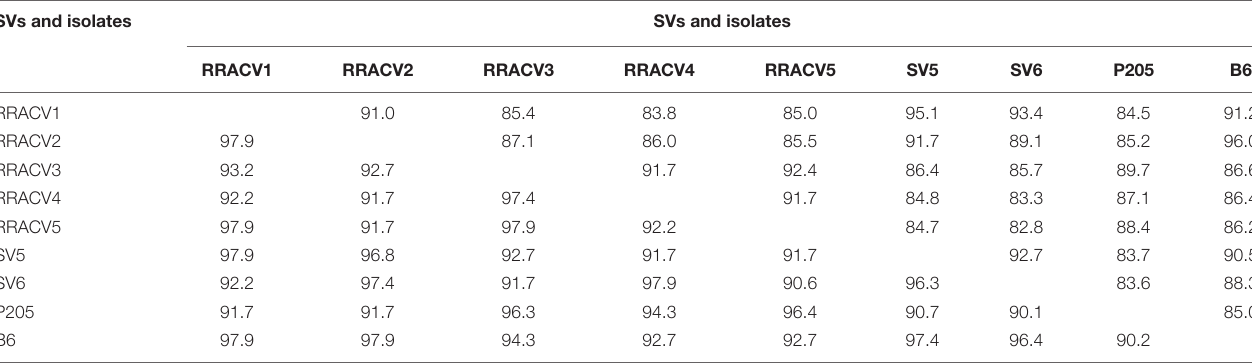
TABLE 2 | Identities of the nucleotide and amino acid sequences of the coat protein gene between the sequence variants (SV) and the isolates of ACLSV found in infected N. occidentalis and an apple tree (PK-51) with ARRD. SVs and